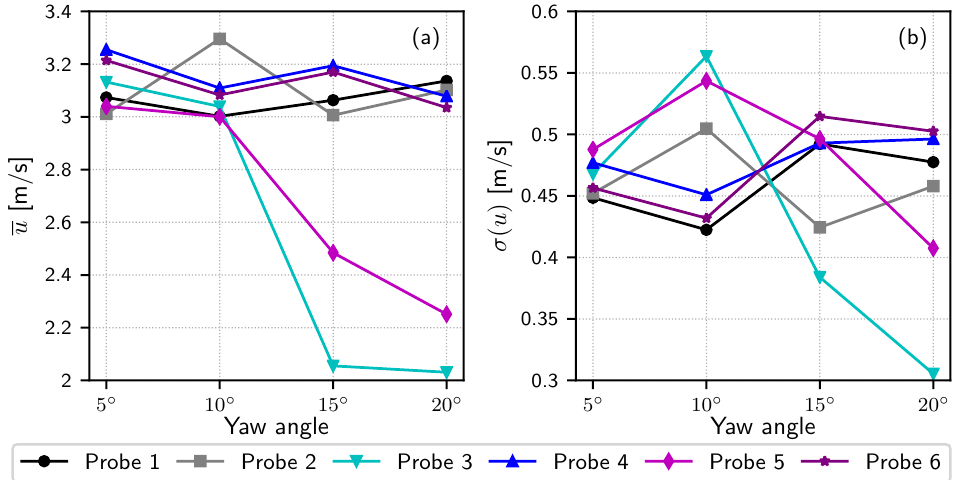
Figure 17. Time average and standard deviation of the velocity u ( I ∞ = 10%, L = 18 m, Rf ≈ 229, TSR = 4.1, σ ( λ ) = 75%). ( a ) Time average of the velocity; ( b ) Standard deviation of the